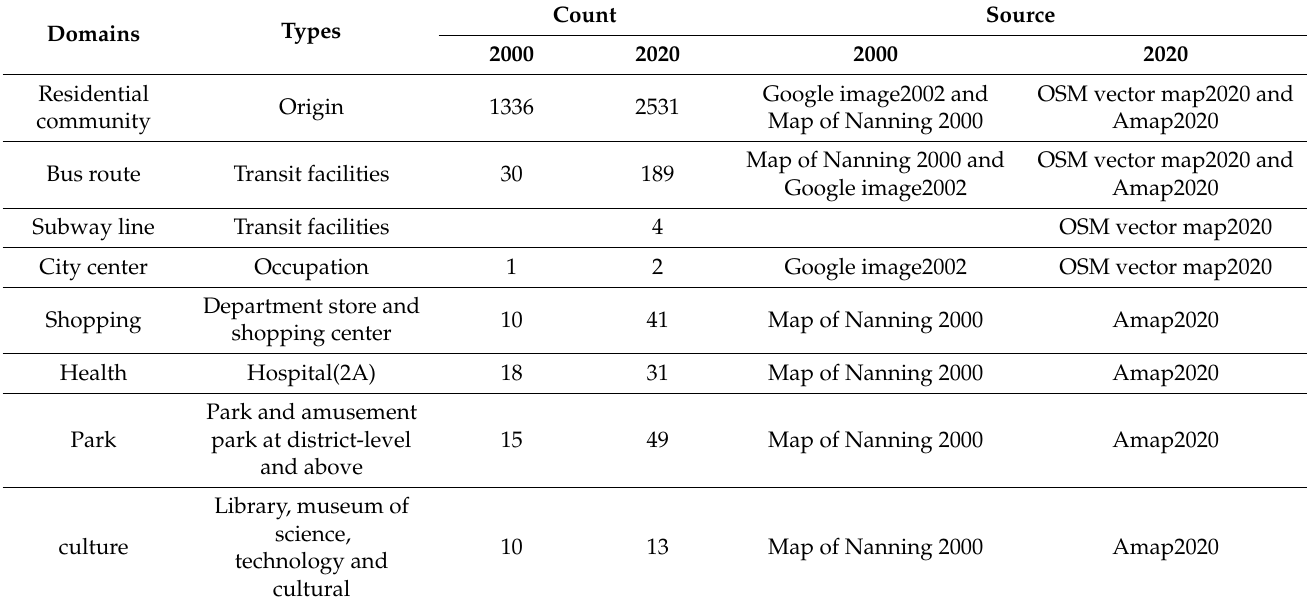
Table 1. Data source of origin, destinations and transit